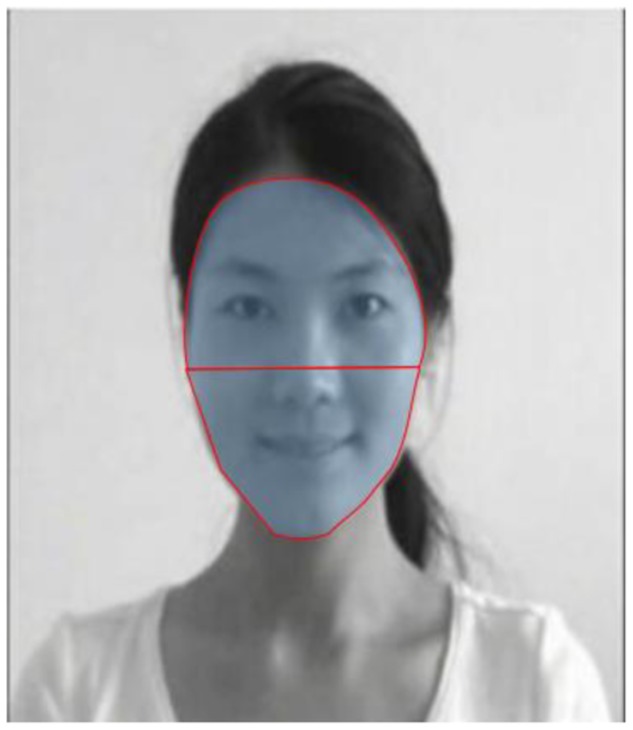
An example of AOIs.